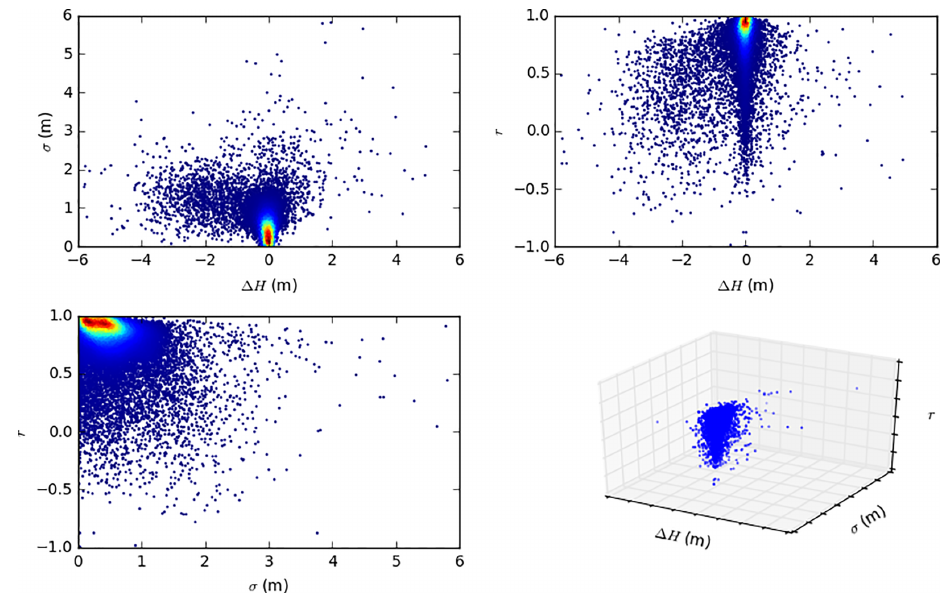
Figure 8. Scatter plots of the three parameters ( (cid:49)H , σ , r) calculated for all the buildings in the study area. The color represents the density of points, wherein red shows the area with the highest density.